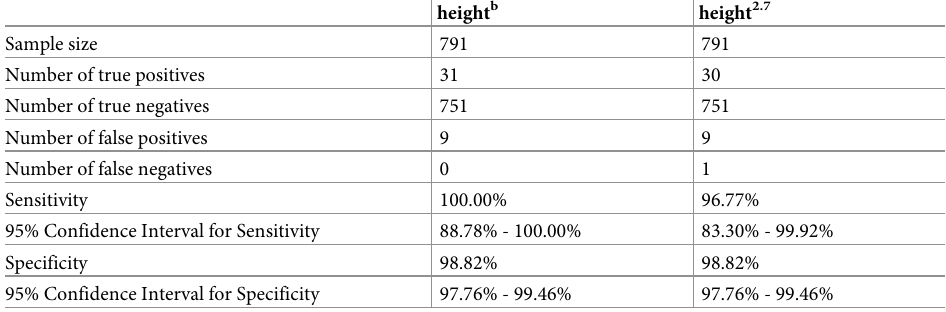
Table 4. Evaluation of sensitivity and specificity of different variants of the allometric method of LVM normaliza- tion in comparison to the LMS method. height b